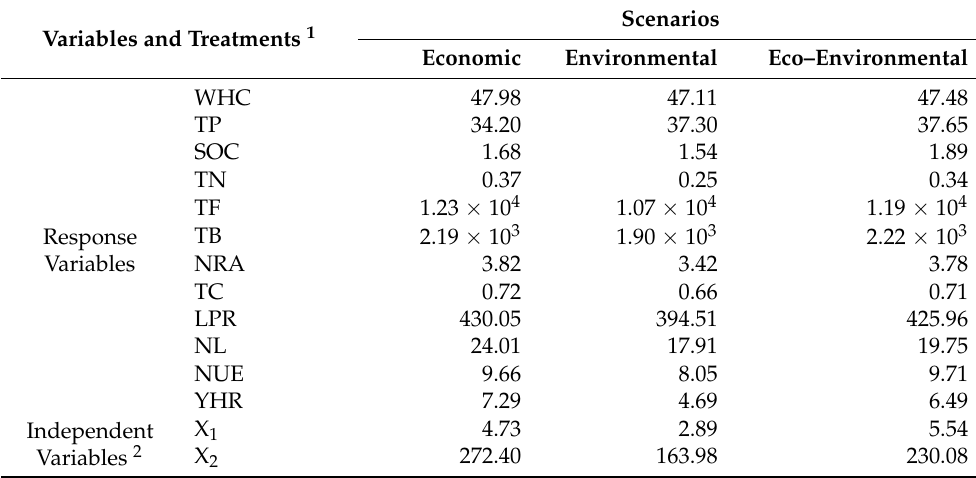
Table 7. Optimized value of in situ biochar briquettes and nitrogen fertiliser for response variables. Scenarios Variables and Treatments 1 Economic Environmental